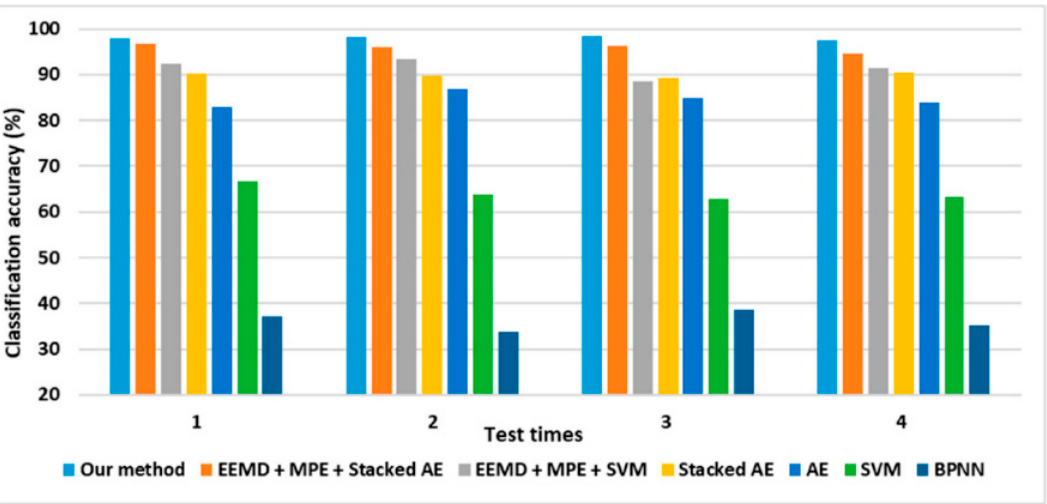
Figure 6. Bearing test ring tests from [108] , Copyright 2019, MDPI. A = fan end bearing; B = electronic motor; C = drive end bearing; D = torque transducer; E = dynamometer.